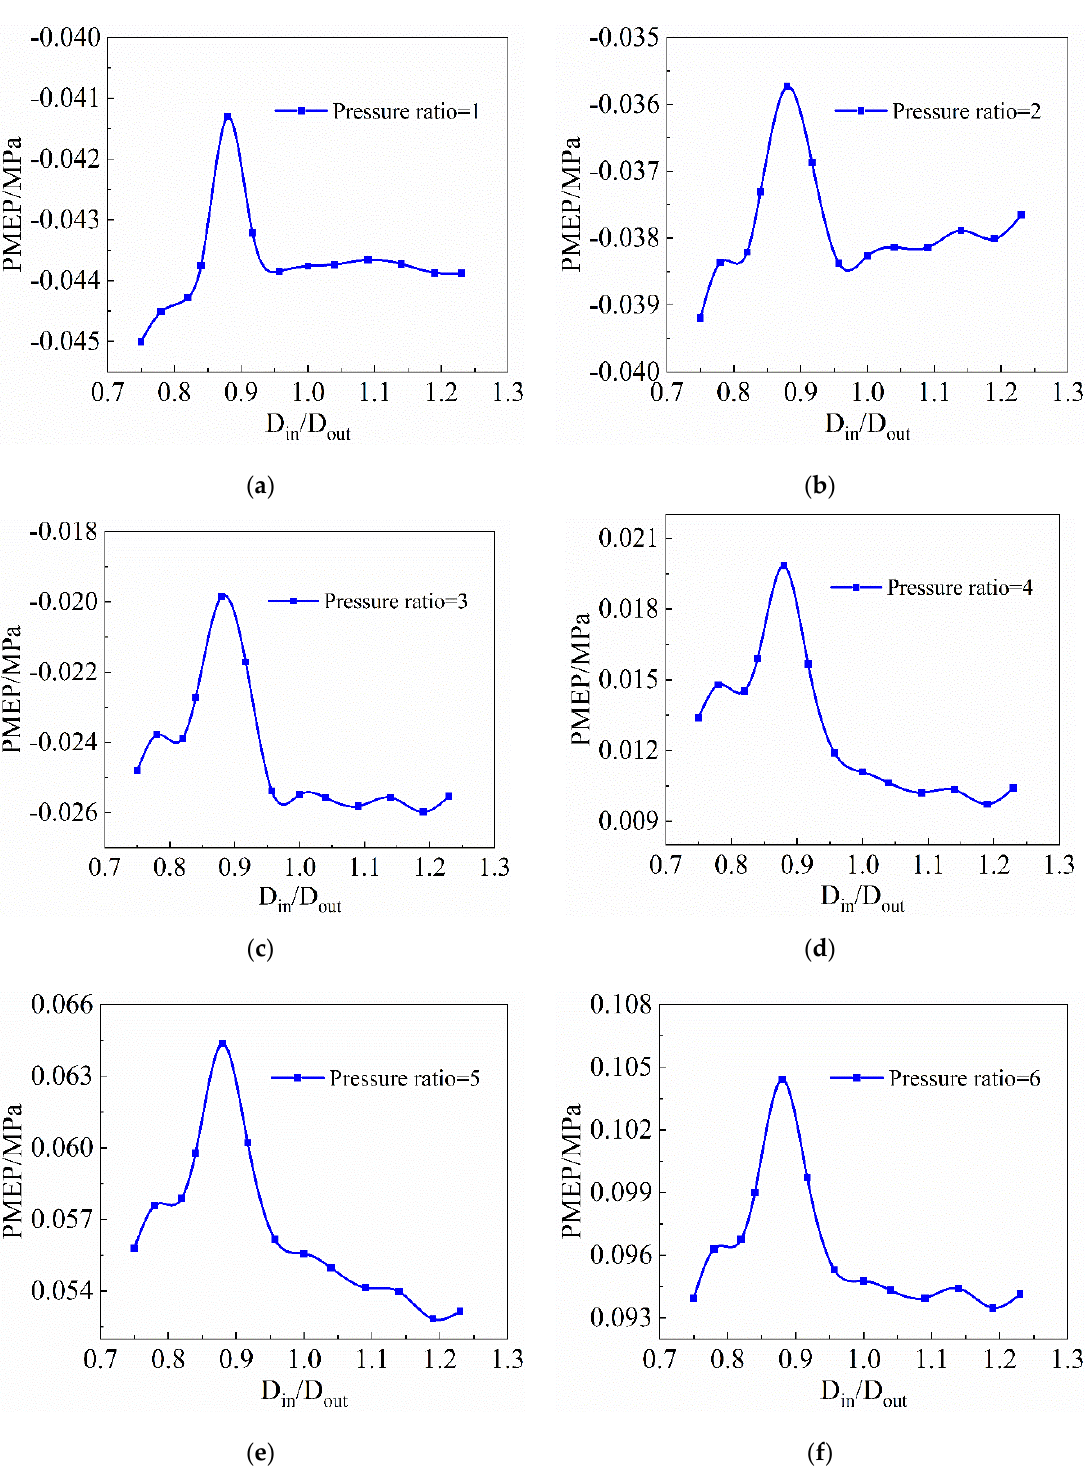
Figure 12. ( a ) PMEP under pressure ratio 1; ( b ) PMEP under pressure ratio 2; ( c ) PMEP under pressure ratio 3; ( d ) PMEP under pressure ratio 4; ( e ) PMEP under pressure ratio 5; ( f ) PMEP under pressure ratio 6.